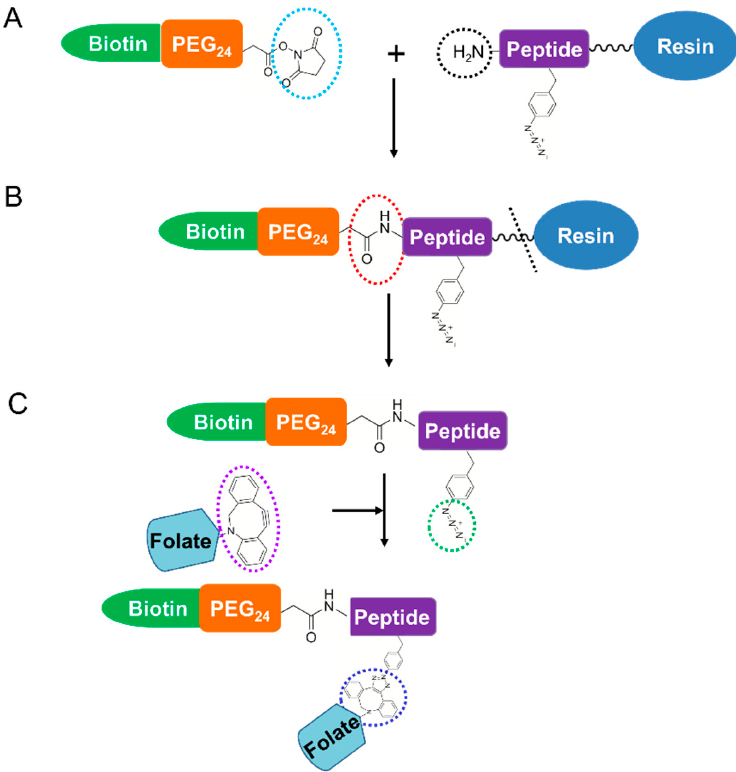
Figure 3. Synthesis procedure for peptide conjugates. ( A ) N -terminal peptide modification with biotin-PEG 24 was achieved by reacting ester NHS (cyan dotted circle) and the NH 2 group of the peptide (black dotted circle).The black wavy line between resin and peptide indicated various peptide lengths. ( B ) After the N -terminal modification with biotin-PEG 24, the amide bond (red dotted circle) was formed. Next, peptide was cleaved from resin (black dotted line). ( C ) The folate-DBCO-AzPhe containing peptide was achieved by the SPAAC click reaction between DBCO (purple dotted circle) of the folate and azide groups (green dotted circle) of the AzPhe in the peptide to form the folate-peptide conjugate via the dibenzocyclooctyne triazole (blue dotted circle).